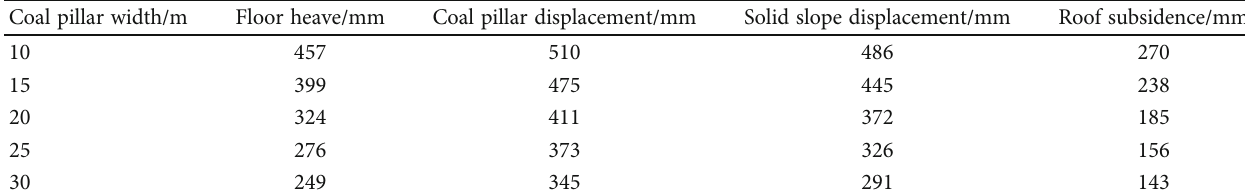
Figure 12: Stresses on coal pillar with di ff erent widths. Table 3: Surface displacement of roadway with di ff erent pillar widths.